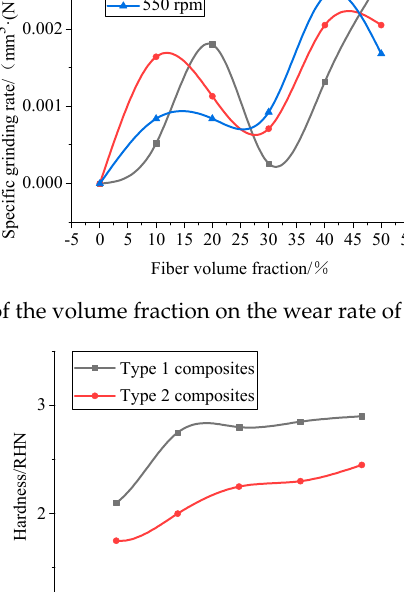
Figure 15. Effect of the volume fraction on the wear rate of type 2 composites.